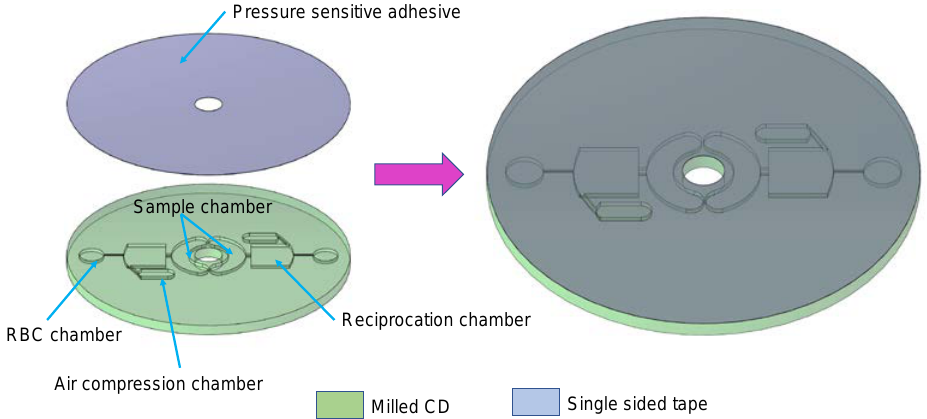
Figure 2. Fabrication and assembly of the integrated CD. The two layers—a milled polyacrylic CD (in green) and a single-sided tape (in gray)—are pressed together to fabricate the integrated disc. The polyacrylic CD (green) is milled to create the sample chamber, the RBC chamber, the reciprocation chamber, and the air compression chamber. The adhesive is punctured using pointed tweezers to create the vent holes and sample inlet holes.